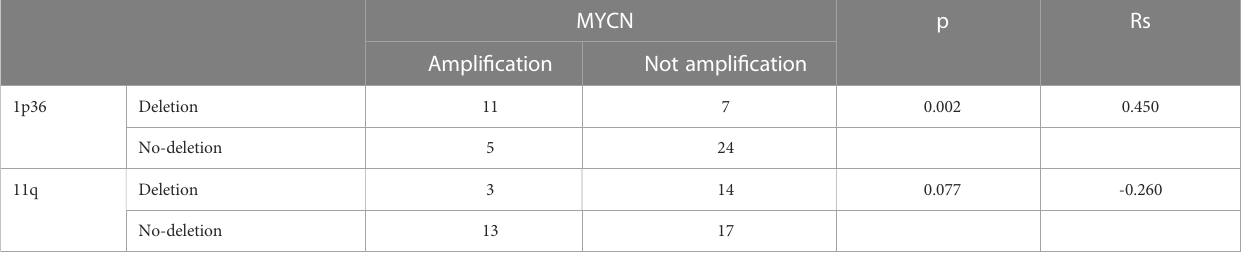
TABLE 4 Correlation between MYCN gene, chromosome 1p36 and 11q.